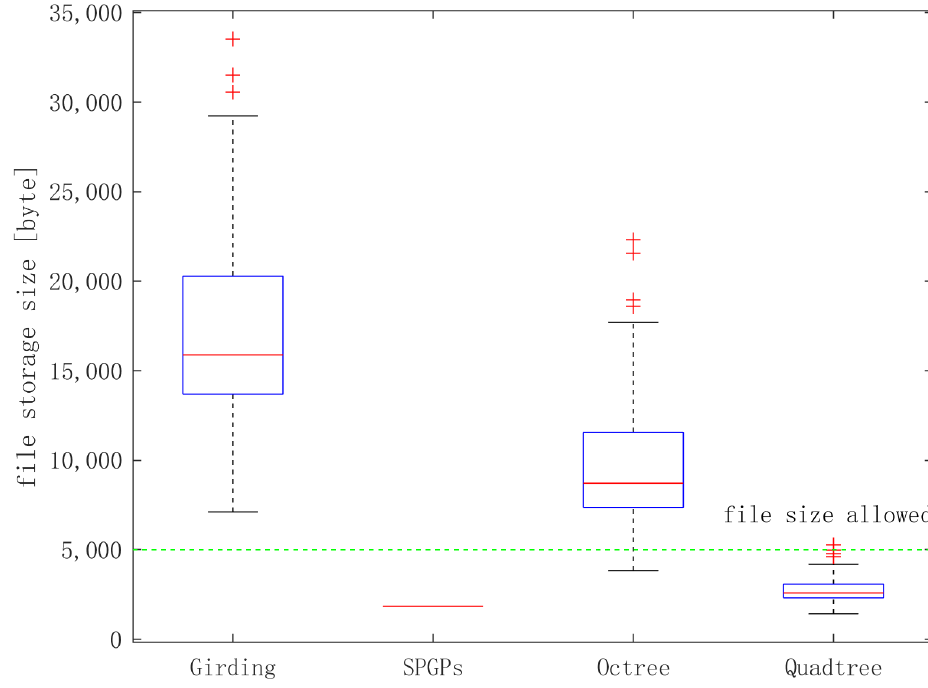
Figure 15. The storage space occupied by the maps of the four algorithms. Table 2. Statistical information on the volume of disk space occupied by four